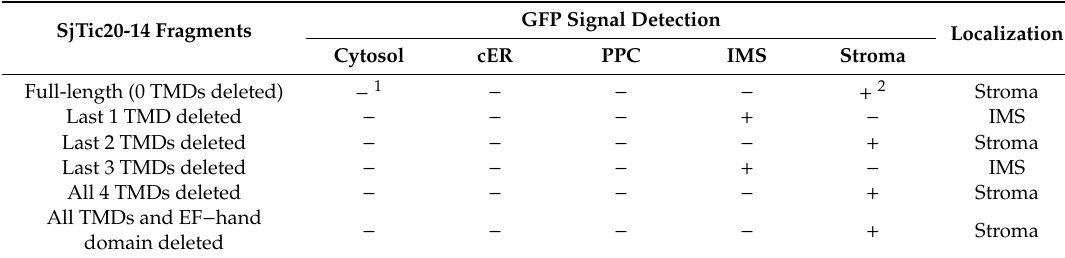
Table 1. Statistical results of the self-assembling GFP